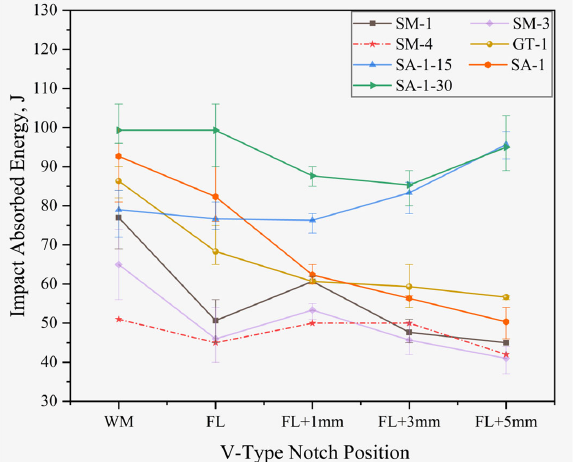
Figure 8. Cryogenic V ‐ notch Charpy impact absorbed energy.